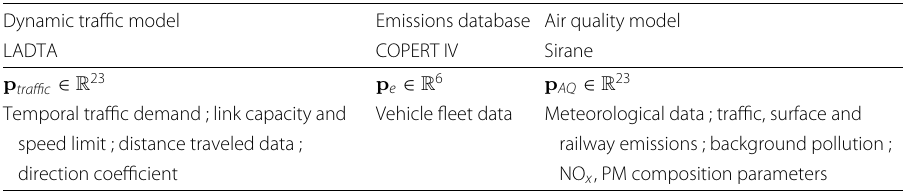
Table 1 Summary of input parameters to the full meta-model chain